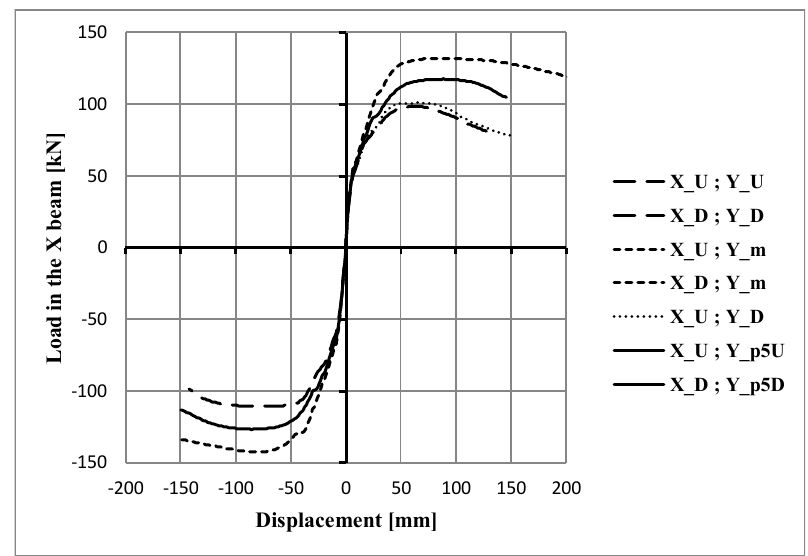
Figure 11. Load displacement results were obtained from parametric FE analyses.